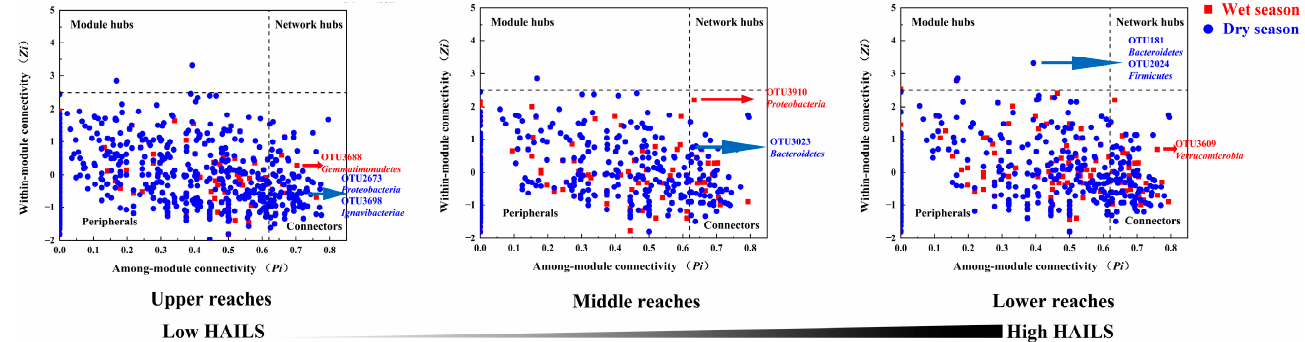
Figure 6. Topological roles of soil fungi during the wet and dry season in the Yuan